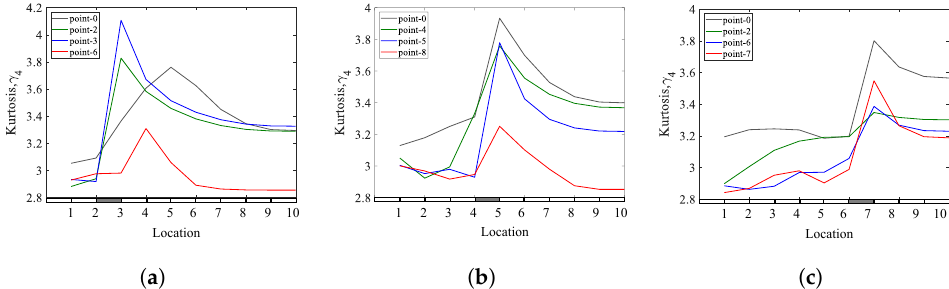
Figure 27. The effect of changing excitation locations on the kurtosis coefficients of a cantilever beam with a single breathing crack: ( a ) q 1 = 0.25; ( b ) q 2 = 0.45; ( c ) q 3 = 0.65.